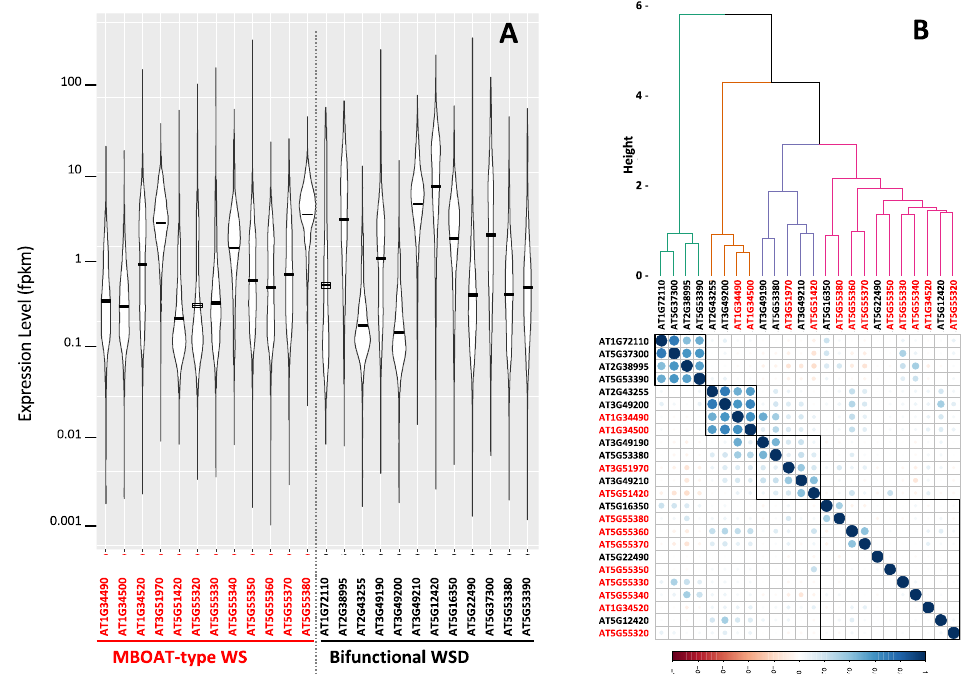
Figure 7. Expression levels and correlations among the Arabidopsis WS and WSD genes. ( A ) Violin plot presentations of the range of expression levels of the 12 WS genes and 11 WSD genes determined from 5200 individual Arabidopsis RNA-Seq experiments downloaded from the NCBI Sequence Read Archive (Table S3); ( B ) correlation of the expression of each WS and WSD genes with all Arabidopsis genes calculated from the 5200 individual Arabidopsis RNA-Seq experiments downloaded from the NCBI Sequence Read Archive (Table S3).